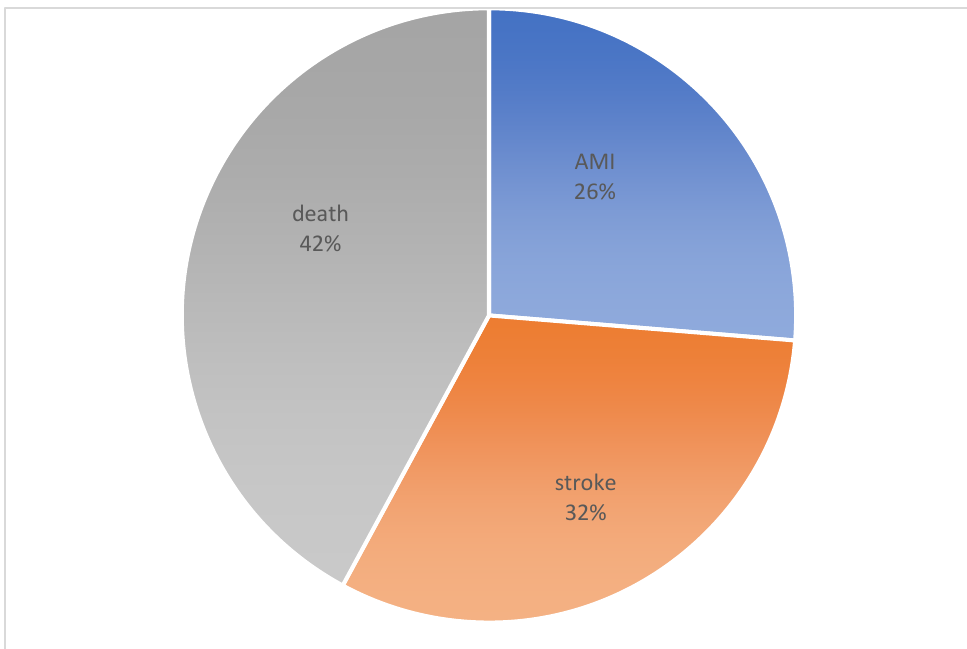
Figure 2. The structure of major adverse cardiovascular event after 18 months. AMI — Acute Myocardial Infarction